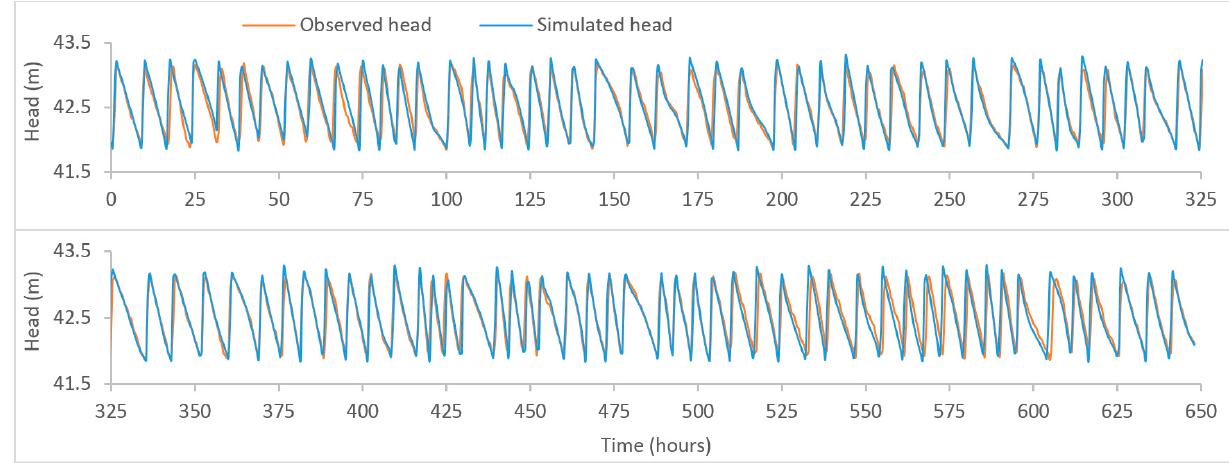
Figure A3. Plot of observed and model-simulated time-series for the head at Meningie tank.